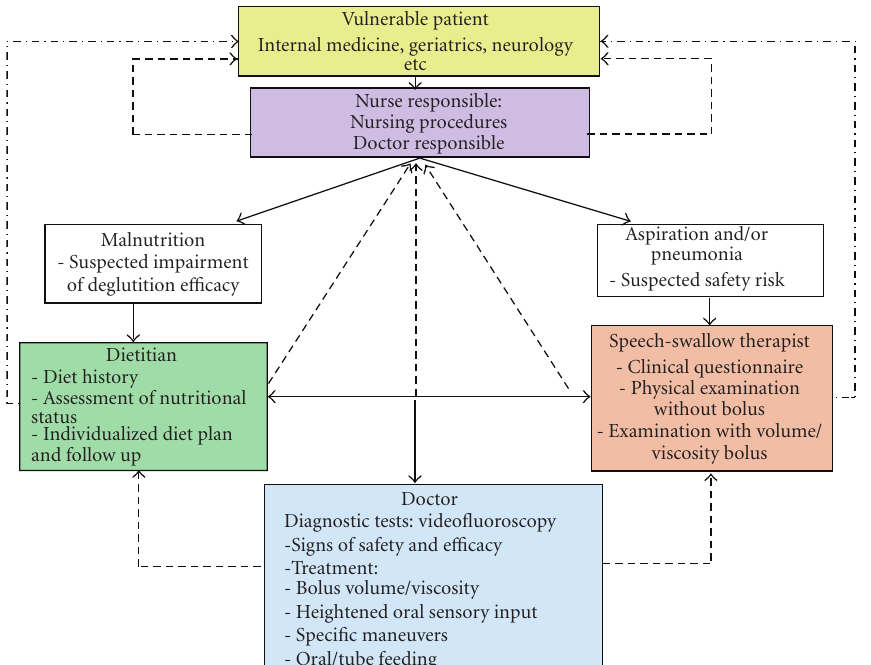
Figure 4: Algorithm for screening, diagnosis and treatment of oropharyngeal functional dysphagia at the Hospital de Matar´o. Barcelona. Spain. Note the involvement of several professional domains of the dysphagia multidisciplinary team and the vertical and horizontal flows of information. The continuous black lines indicate the diagnostic screening strategy of patients at risk; the broken lines indicate flow of information on patient status, and broken dotted lines indicate therapeutic